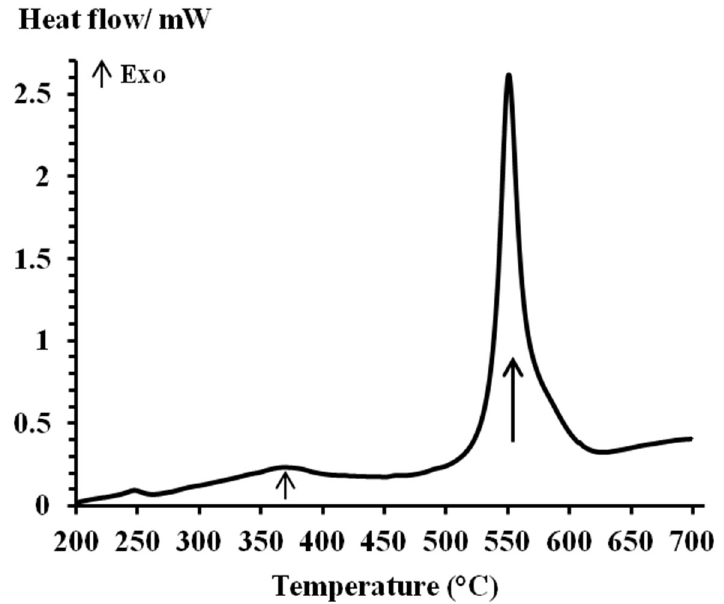
Figure 7. DSC scan for Fe 70 Ni 12 B 16 Si 2 alloy after 150 h of milling (heating rate of 20 °C min −1 ).